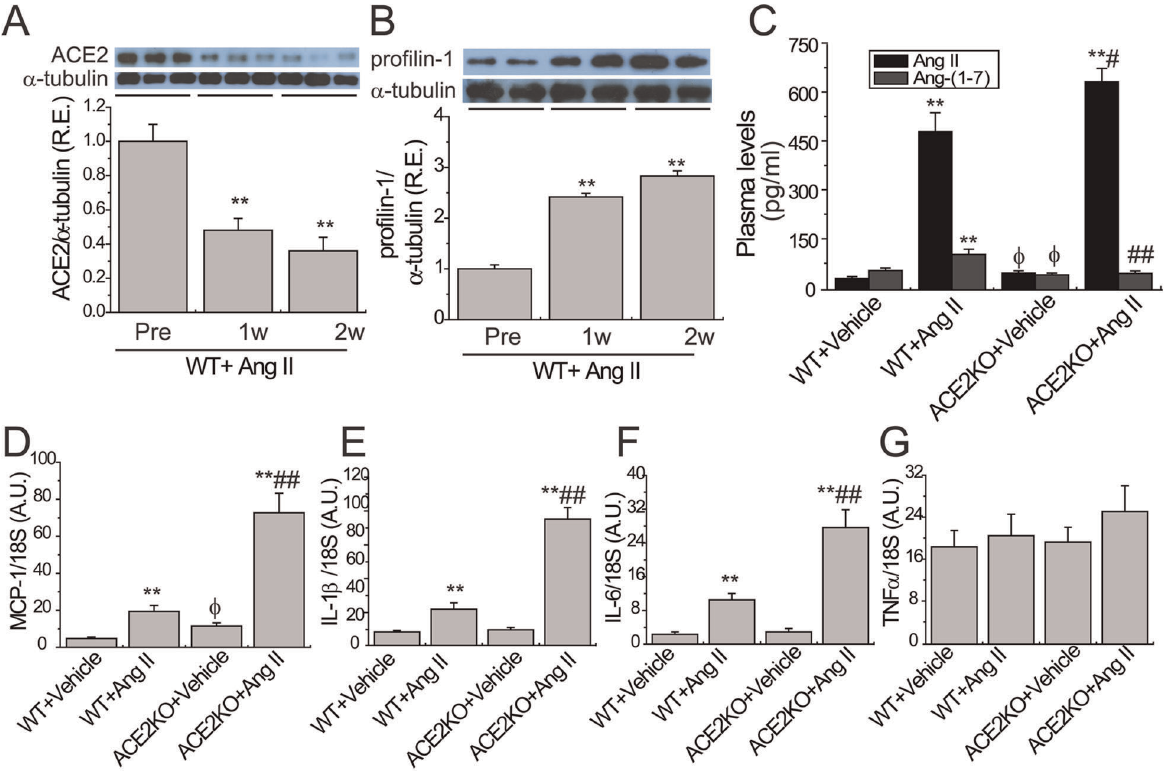
Figure 1. Ang II-mediated aortic expressions of ACE2, profilin-1, and inflammatory cytokines in mice. Representative Western blot analysis with quantification exhibited aortic expressions of ACE2 (A; 90 kD) and profilin-1 (B; 15 kD) at 0, 1 and 2 weeks after Ang II infusion in WT mice (n=5). R.E.=relative expression; a -tubulin (55 Kd) was used as an endogenous control. ** P , 0.01 compared with pre-treatment group. Plasma Ang II and Ang-(1–7) levels (C) were measured in WT and ACE2KO mice in response to Ang II (n=10). TaqMan real-time PCR analysis revealed the mRNA expressions of inflammatory cytokines including MCP-1 (D), IL1 b (E), IL6 (F), and TNF a (G) in mice (n=6 2 8). A.U.=arbitrary units; MCP-1, monocyte chemoattractant protein-1; IL1 b , interleukin-1 b ; IL6, interleukin-6;TNF a , tumor necrosis factor- a . 18S rRNA was used as an endogenous control. ** P , 0.01 compared with corresponding vehicle-treated group; # , P , 0.05 ## , P , 0.01 compared with WT + Ang II group; w , P , 0.05 compared with WT + vehicle group.